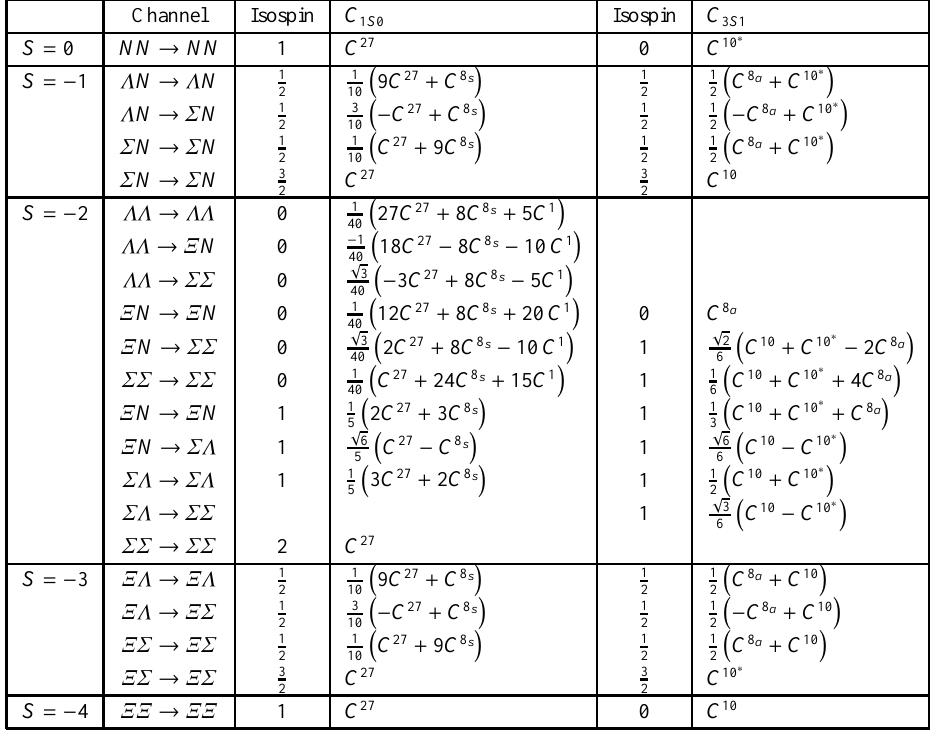
Table 1. Various LO baryon-baryon contact potentials for the 1 S 0 and 3 S 1 partial waves in the isospin basis. C 27 etc. refers to the corresponding SU(3) f irreducible representation